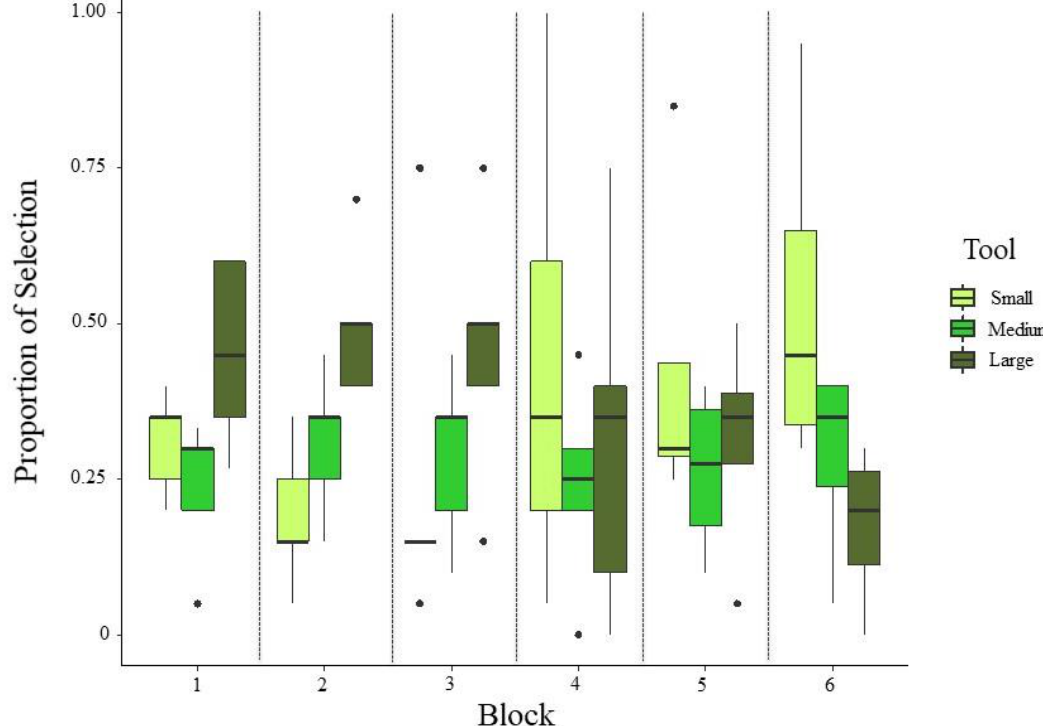
Box and Whisker Plot Showing the Proportions of Selection of the Small, Medium and Large Tool in Experiment 1a (Block 1-4) and Experiment 1b (Block